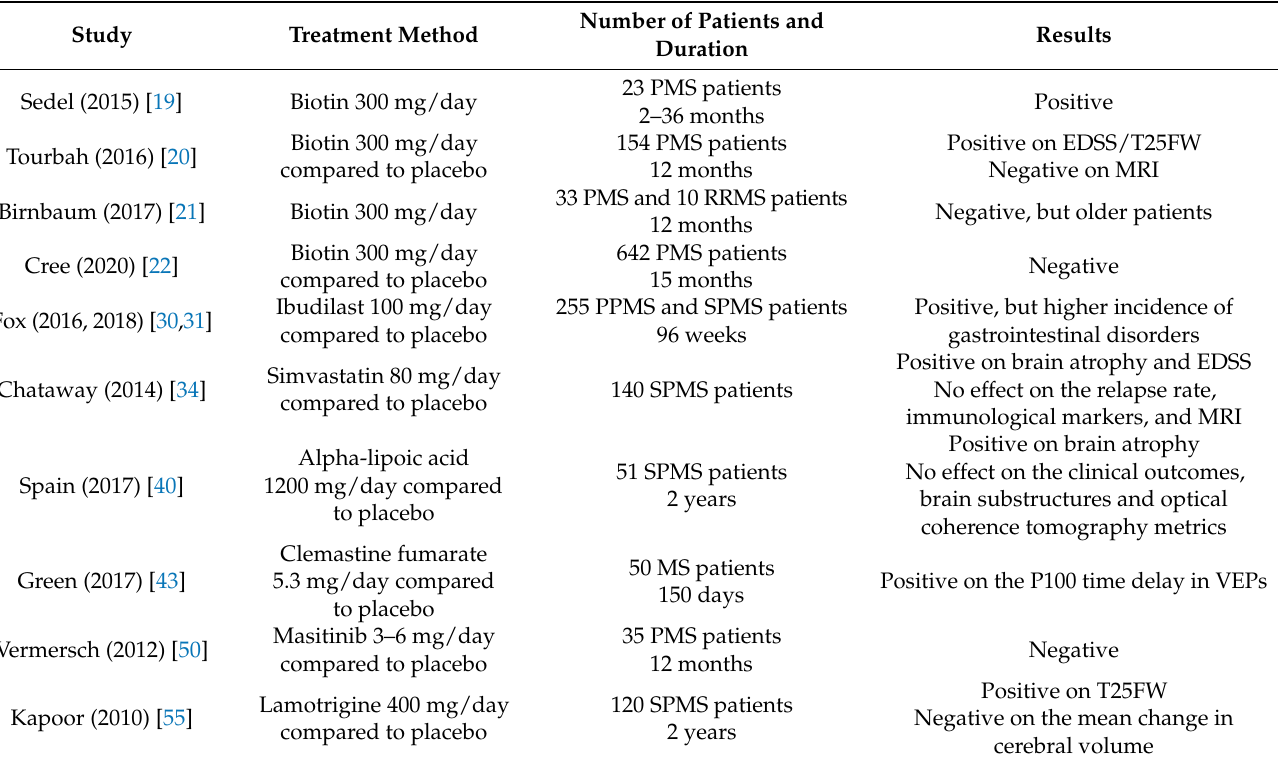
Table 2. A summary of completed clinical trials in patients with progressive multiple